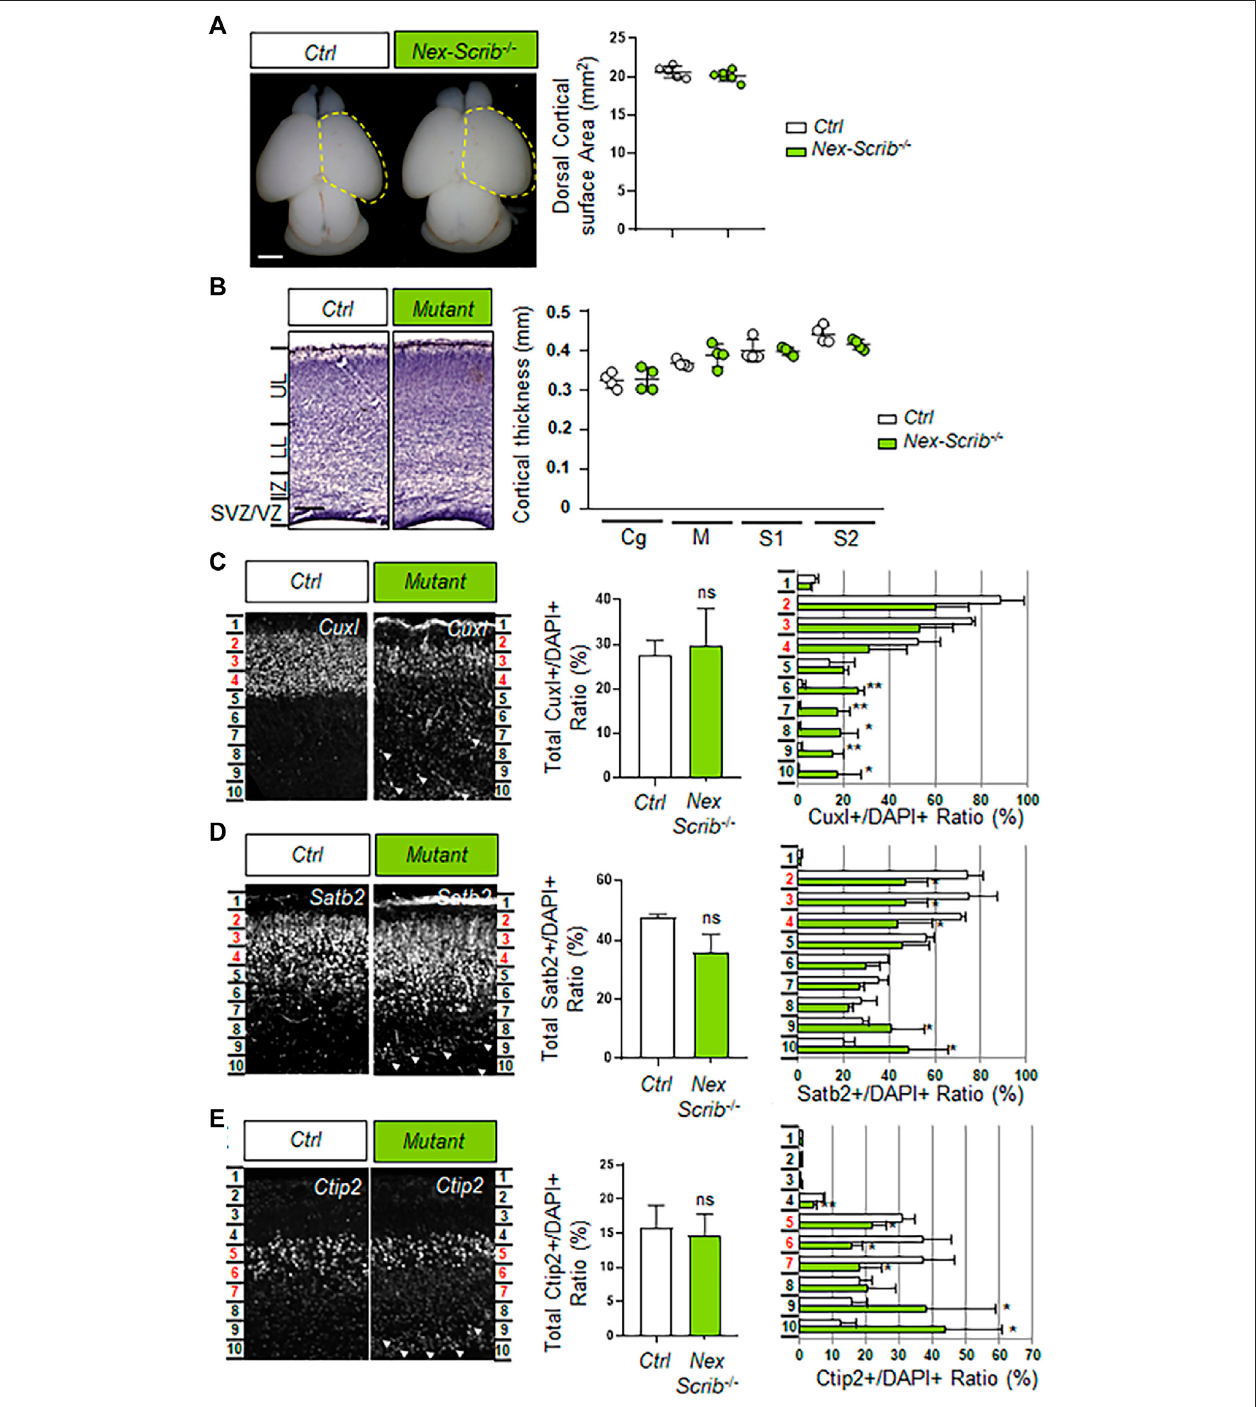
FIGURE 2 | Deletion of Scrib speci fi cally in postmitotic pyramidal neurons mostly impacts cortical layering during brain development. (A) Dorsal views of P0 Nex- Scrib − / − cKOmousebrains.Corticalplateareasaremarkedwithayellowdashedlineforcomparisonandquanti fi cation.Statisticalanalysisviaatwo-tailed t -testusingat least fi ve brains per genotype from at least three independent experiments. Error bars indicate the SEM. Scale bar: 1 mm. (B) Representative hematoxylin staining of coronal sections from thenewborn Nex-Scrib − / − cKO motor cortex at thecaudallevel and its control. Nosigni fi cantreduction ofthecaudalmotorcortexthickness was observed in the mutant. Cortical plate thickness was measured radially from the top of the upper layer (UL) to the bottom of the lower layer (LL) of the cortex. IZ: intermediate zone, SVZ: subventricular zone, VZ: ventricular zone. Statistical analysis via a two-tailed t -test using at least four measurements per genotype from at least three independent experiments. Error bars indicate the SEM. Scale bar: 0.2 mm. (C – E) Representative immuno fl uorescence staining of CuxI (C) , Satb2 (D) , and